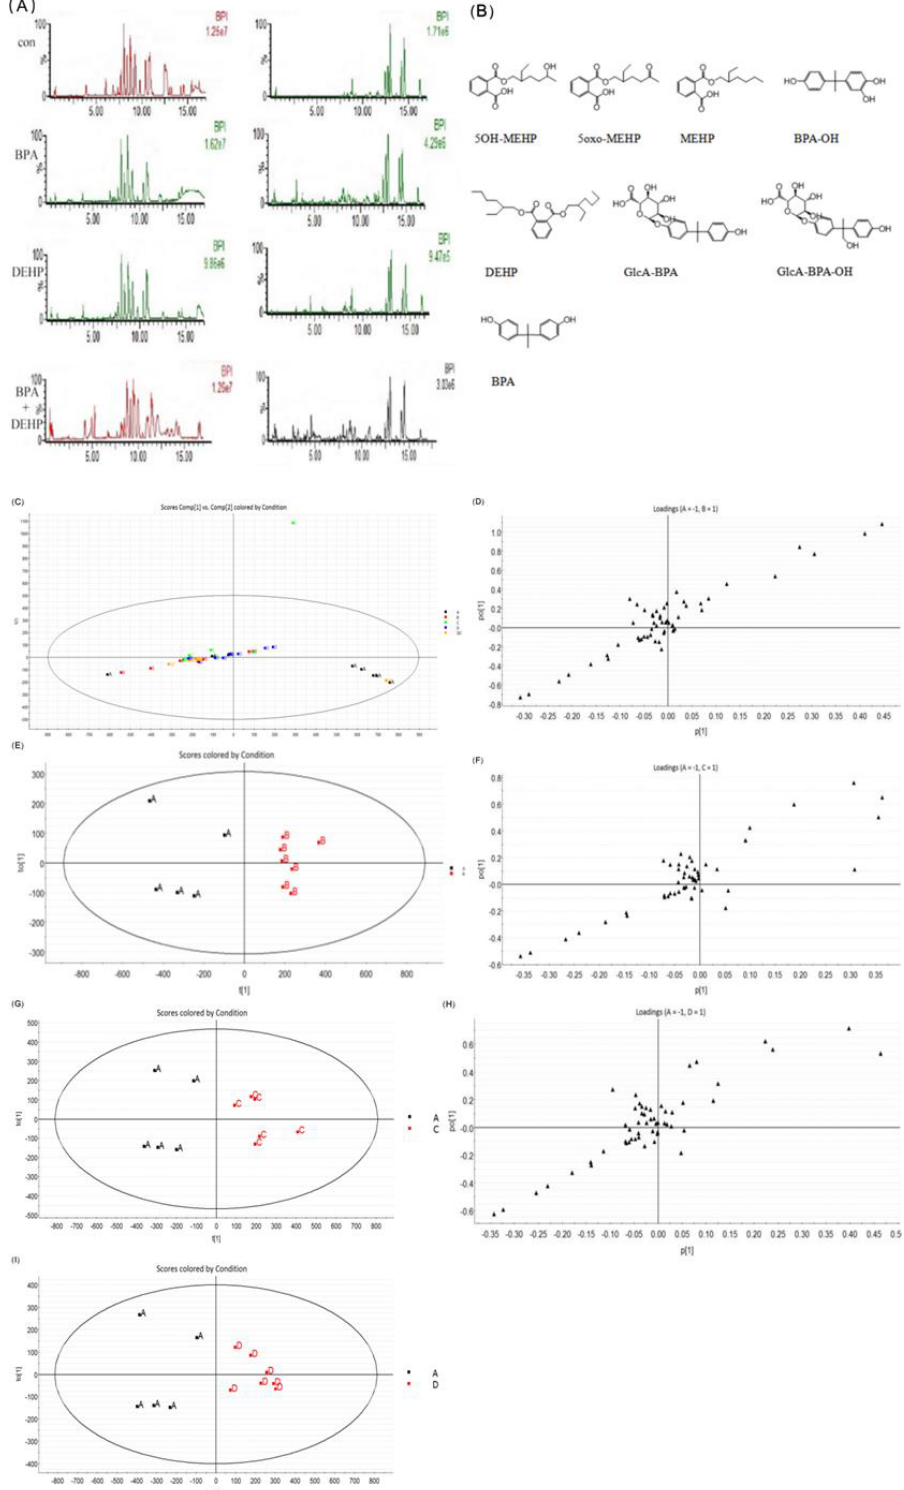
Figure 1. BPI chromatogram of blood samples from each group in positive (left) and negative (right) ion modes ( A ). Chemical structure of BPA, DEHP and its metabolites ( B ). The plasma principal component analysis score of the mother between the control group and the exposed group. Vector, loading map ( C – I ). Data are presented as mean ± SEM. [Note]: A: corn oil group, B: BPA group, C: DEHP group, D: BPA+DEHP group. Each represents a